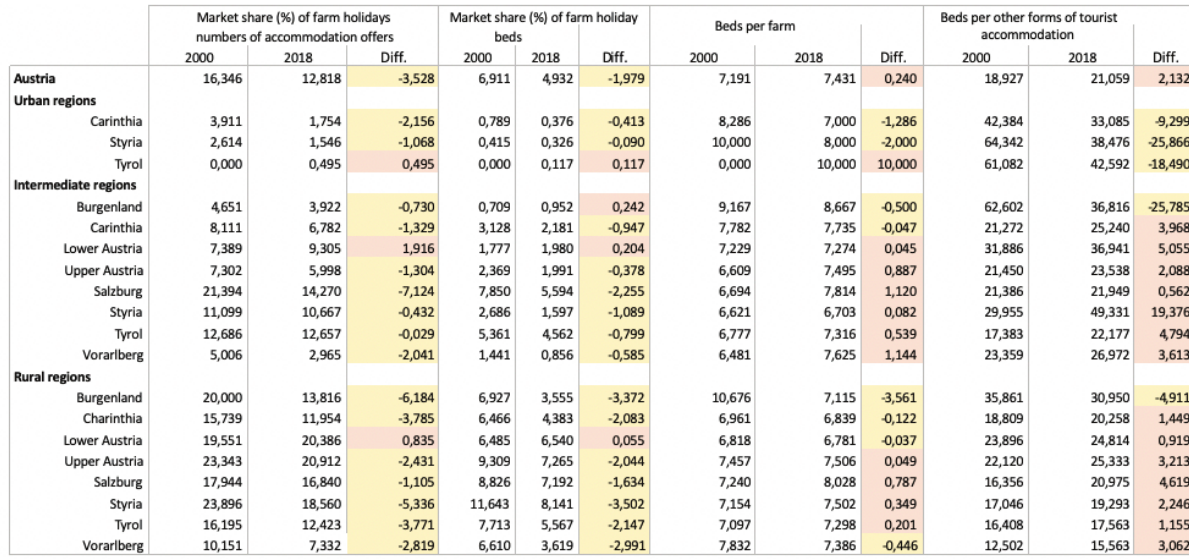
Table 2: Market share of farm holidays in terms of the number of accommodation offers and beds as well as the numbers of beds per farm and ‘other forms of tourist accommodation’ by NUTS3 regions, 2000 and 2018 (Statistics Austria